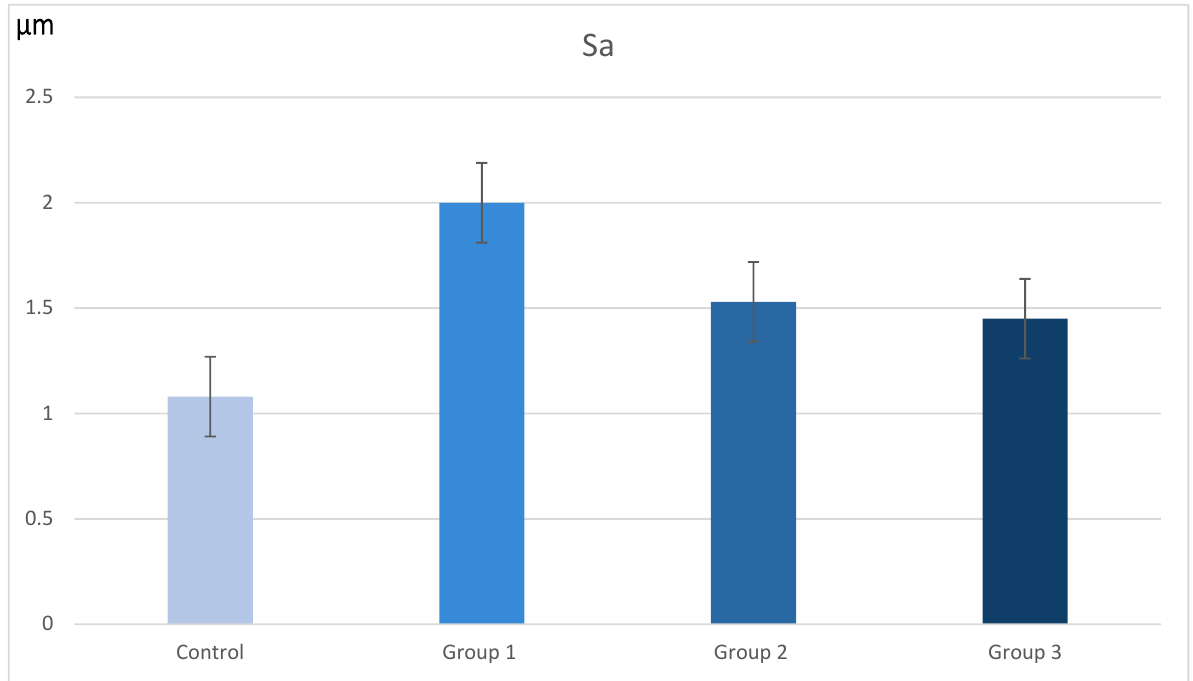
Figure 3. Bar diagram of the Sa variable values in µm ( p -value < 0.001) for the three groups. Table 3. Normality tests performed for each variable (Sa, Sq, Sz) and group at a 95% confidence interval. The red color stated for the statistically significant values.